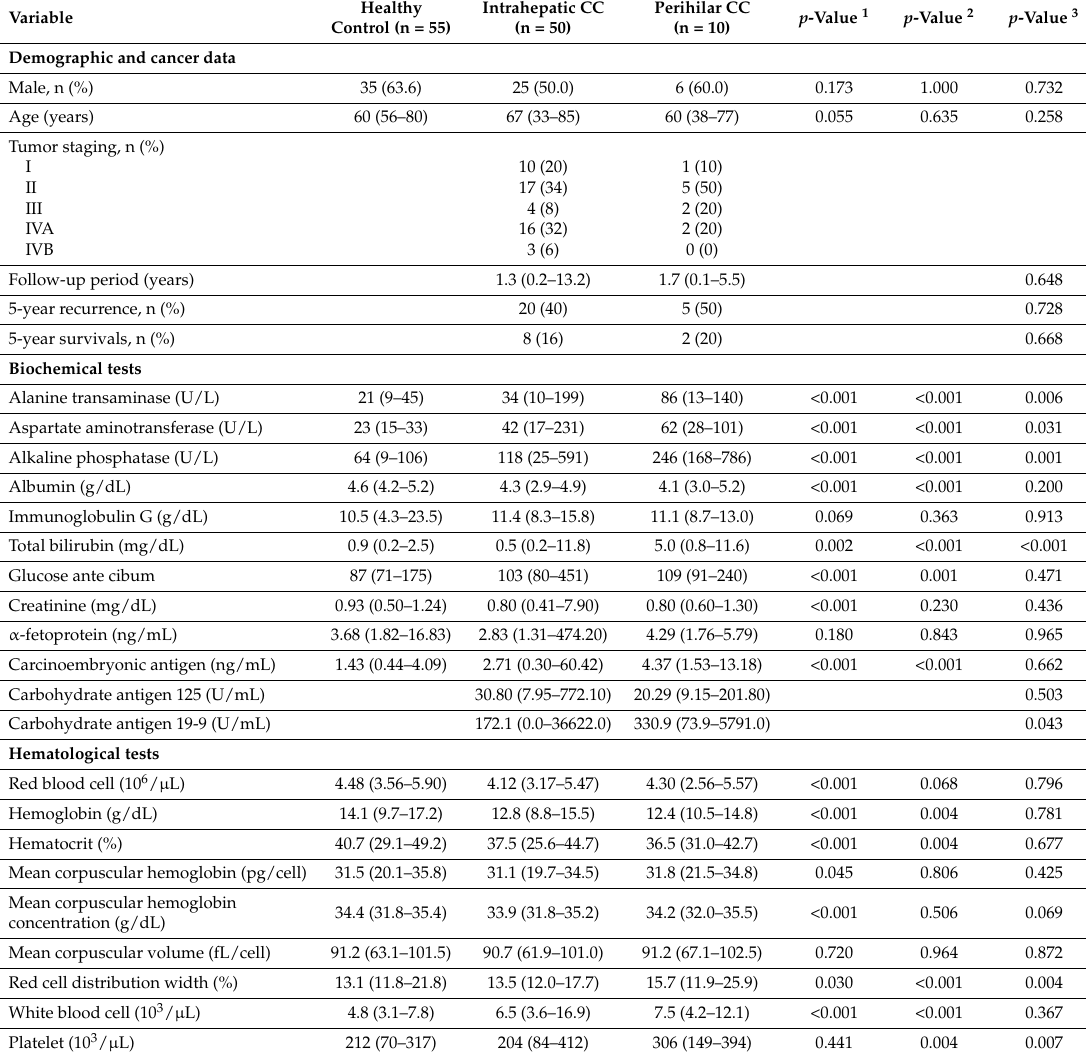
Table 1. Characteristics of healthy controls and patients with cholangiocarcinoma (CC).